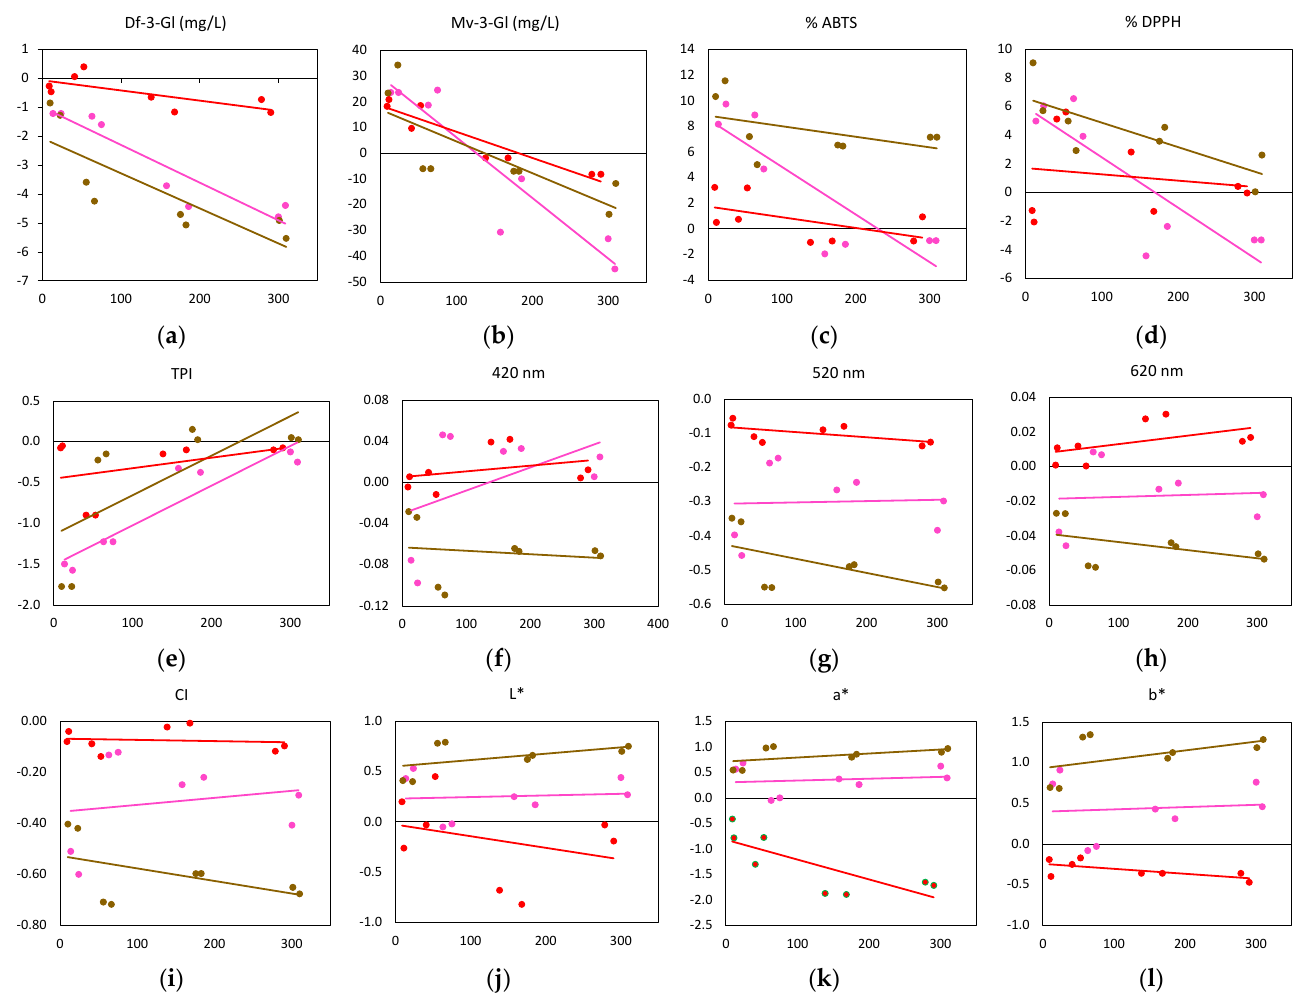
Figure 5. Oxygen consumed (hPa, X -axis) and the change in each parameter compared to the inert condition (Sat-0), Y -axis for W-A (pink), W-B (brown), and W-C (red) for different time (days, Y - axis). ( a ) Df-3-Gl: delphinidin-3-O-glucoside; ( b ): Mv-3-Gl: malvidin-3-O-glucoside; ( c ) %ABTS: Antioxidant capacity; ( d ) %DPPH: Antioxidant capacity; ( e ) TPI: Total Phenols Index; ( f ) 420 nm: absorbances at 420 nm; ( g ) 520 nm: absorbances at 520 nm; ( h ) 620 nm: absorbances at 420 nm; ( i ) CI: Color Intensity; ( j ) L*: black to white lightness; ( k ) a*: red to green; ( l ) b*: blue to yellow.